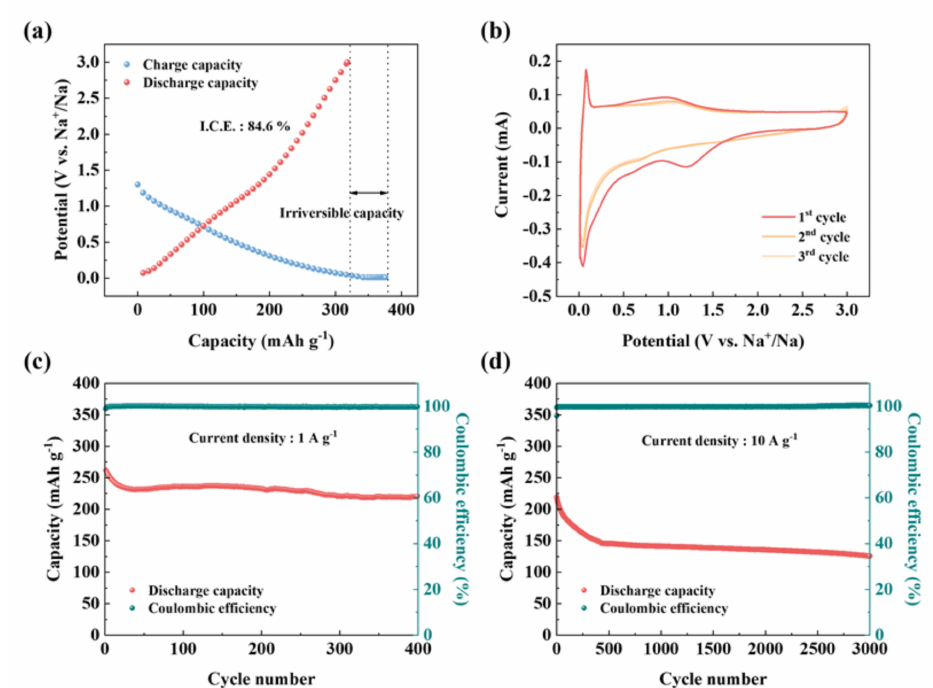
Figure 4. ( a ) Charge/discharge curves of SP/C during the first cycle; ( b ) CV curves of SP/C at a scan rate of 0.2 mV s − 1 ; ( c ) cycling performance of SP/C in SIB at current densities of 1 A g − 1 and ( d ) 10 A g − 1